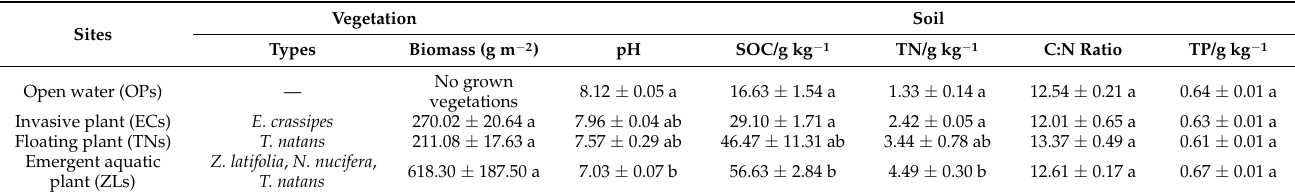
Table 1. The physicochemical characteristics at the four sites.